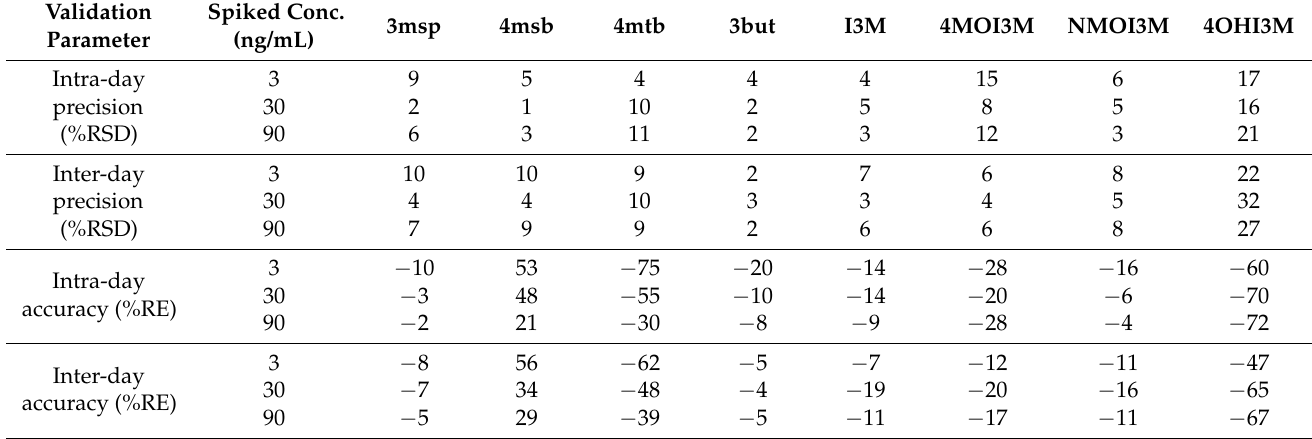
Table 2. Intra-day and inter-day precision and accuracy of intact glucosinolates ( n = 6). Glucosinolate mixed standard solutions were spiked into the blank root matrix of Lamium with the purpose of obtaining the three concentration levels of a low, medium and high (3, 30 and 90 ng/mL) in the final extract. Full names and abbreviations: glucoraphanin (4msb),